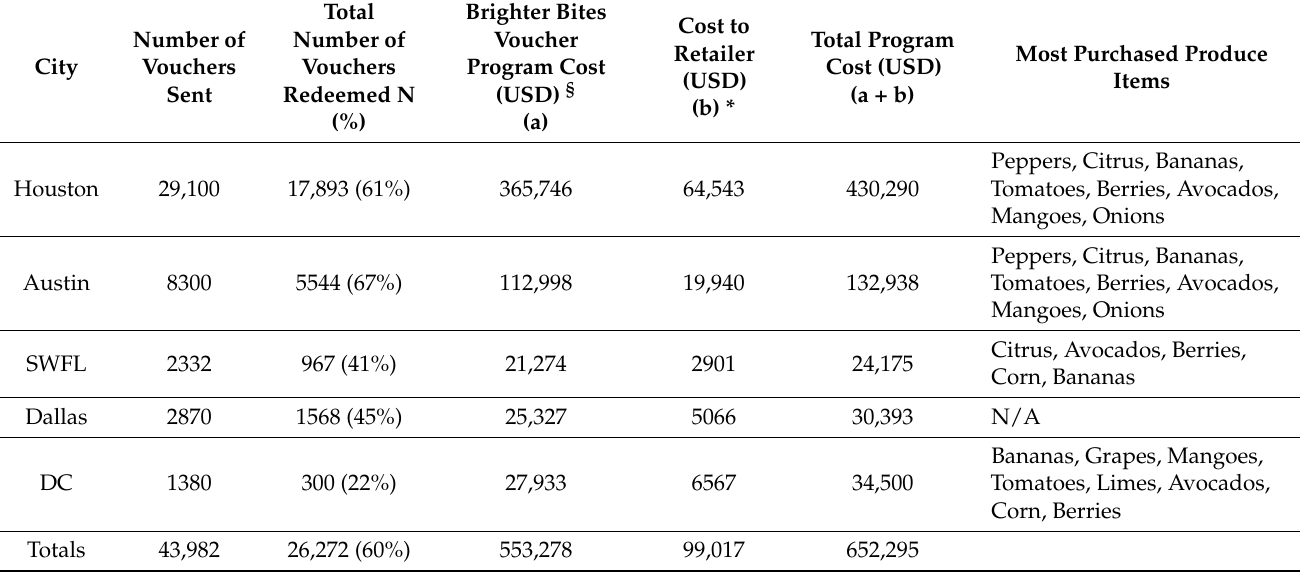
Table 1. Brighter Bites produce voucher program costs and voucher redemption